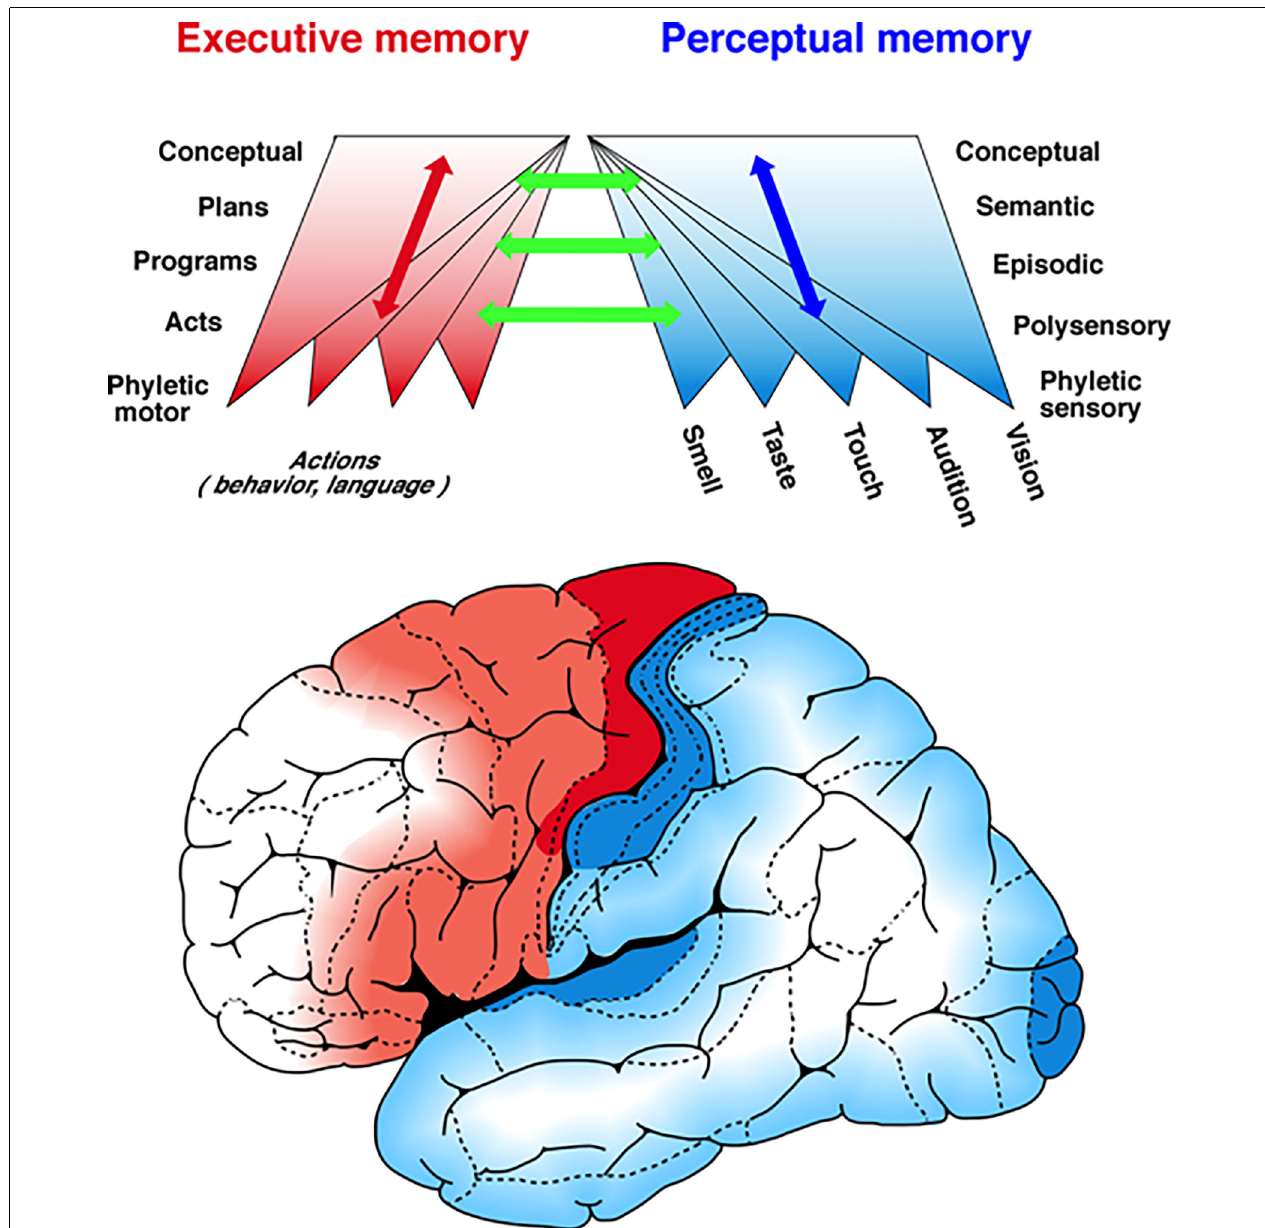
FIGURE 1 | A schema of the hierarchies of cortical memory. The figure portrays in a highly schematic manner a mesoscopic view of the distribution of memory networks. Two hierarchies of memory are shown spread-out tangentially to the cortical surface of the left hemisphere: one in posterior cortex, perceptual, for memories acquired through the senses ( blue to white) and the other in the frontal cortex, executive, for memories acquired through action ( red to white) . The two color gradients mark the ascending hierarchies of memory formation and deposition, from the most concrete, sensory- and motor-related, in the lower levels, to the most abstract and complex in the higher levels of both hierarchies. Up each hierarchy, as memory networks accrue and find their hierarchical niche, they connect with preexisting ones at every level by reasons of similarity and common features. As the upper figure implies, the networks of memory and knowledge (semantic memory) are formed by convergence as well as divergence of associative connections. The two bi-directional arrows, one blue and the other red indicate not only the ascending and descending connections within each hierarchy but also the heterarchical connectivity in some memories and their networks. The green arrows symbolize the connections between hierarchies that play such a critical role in the perception-action cycle. From Fuster